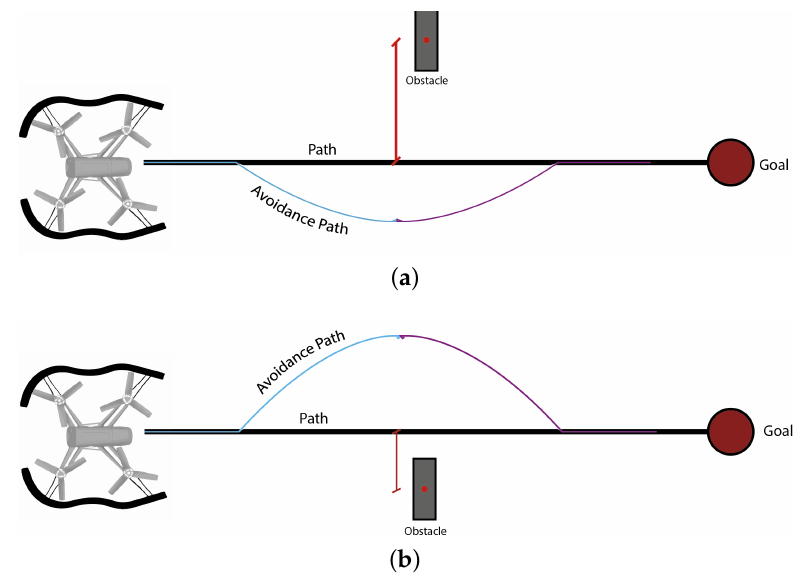
Figure 13. Avoidance path for different obstacles position. ( a ) Obstacle on left side far from the path center; ( b ) obstacle on right side near from the path center.